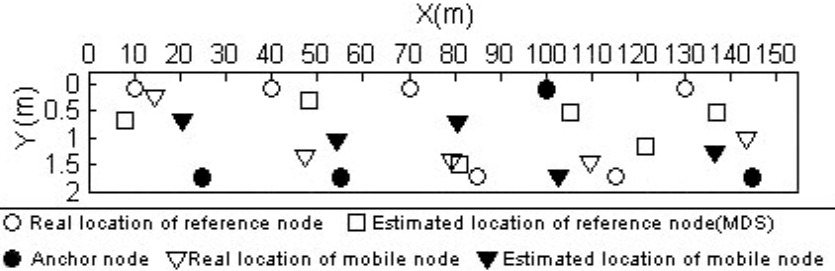
Figure 14. Performance comparison of anchor-free localization